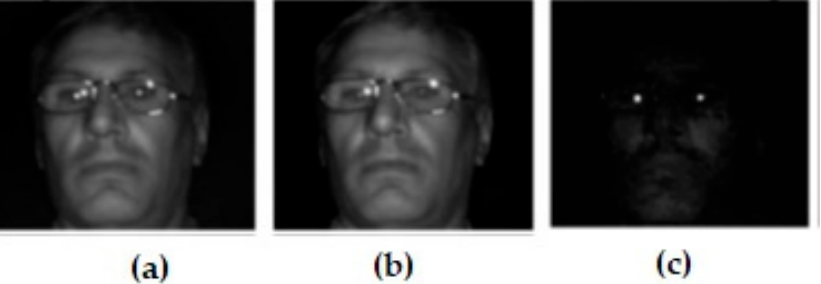
Figure 1. How to obtain driver pupils from two images. ( a ) bright-eye image; ( b ) dark-eye image; ( c ) difference image [21].